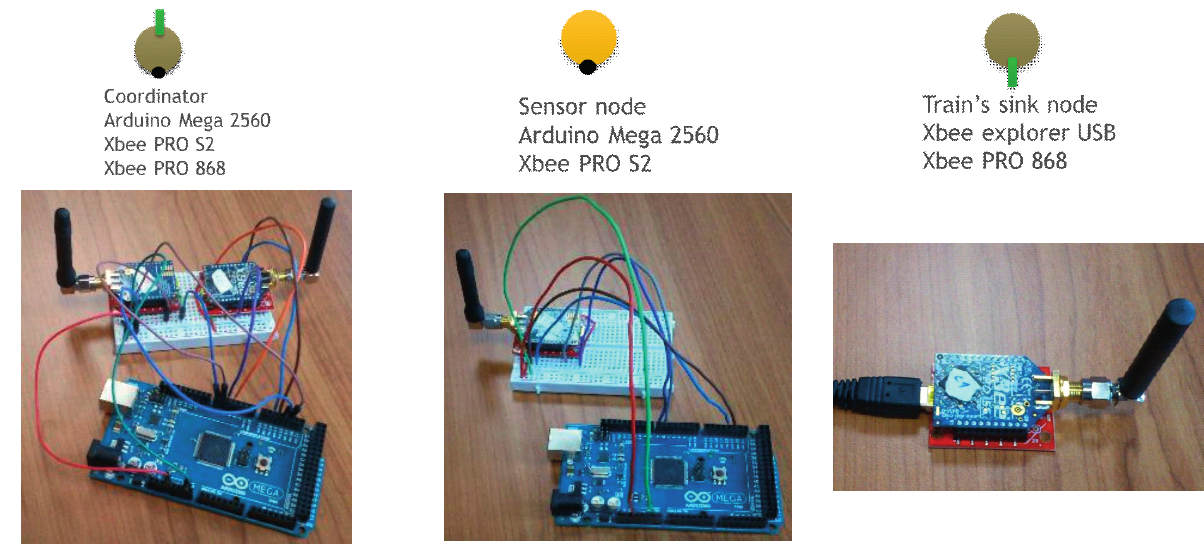
Figure 17. Devices of the monitoring system.